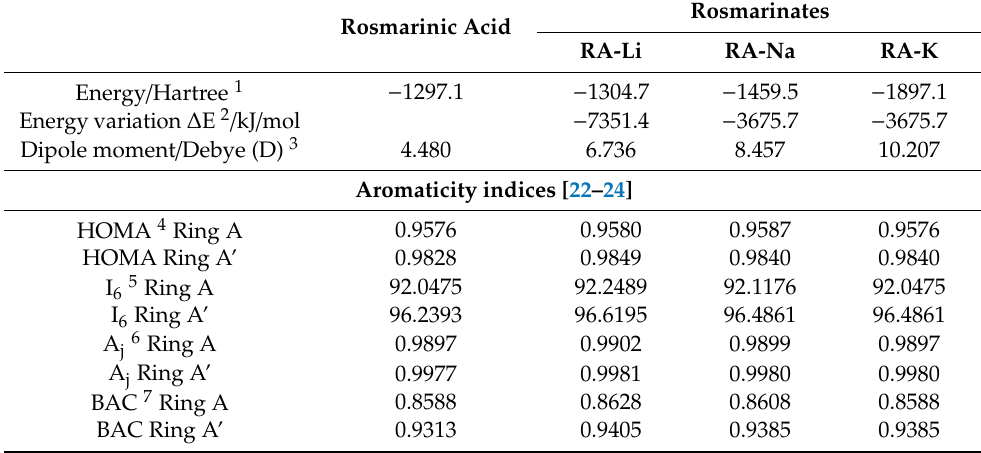
Table 2. Values of dipole moment, energy as well as aromaticity indices calculated using B3LYP / 6-311 + G(d.p) method for rosmarinic acid and its lithium, sodium, and potassium